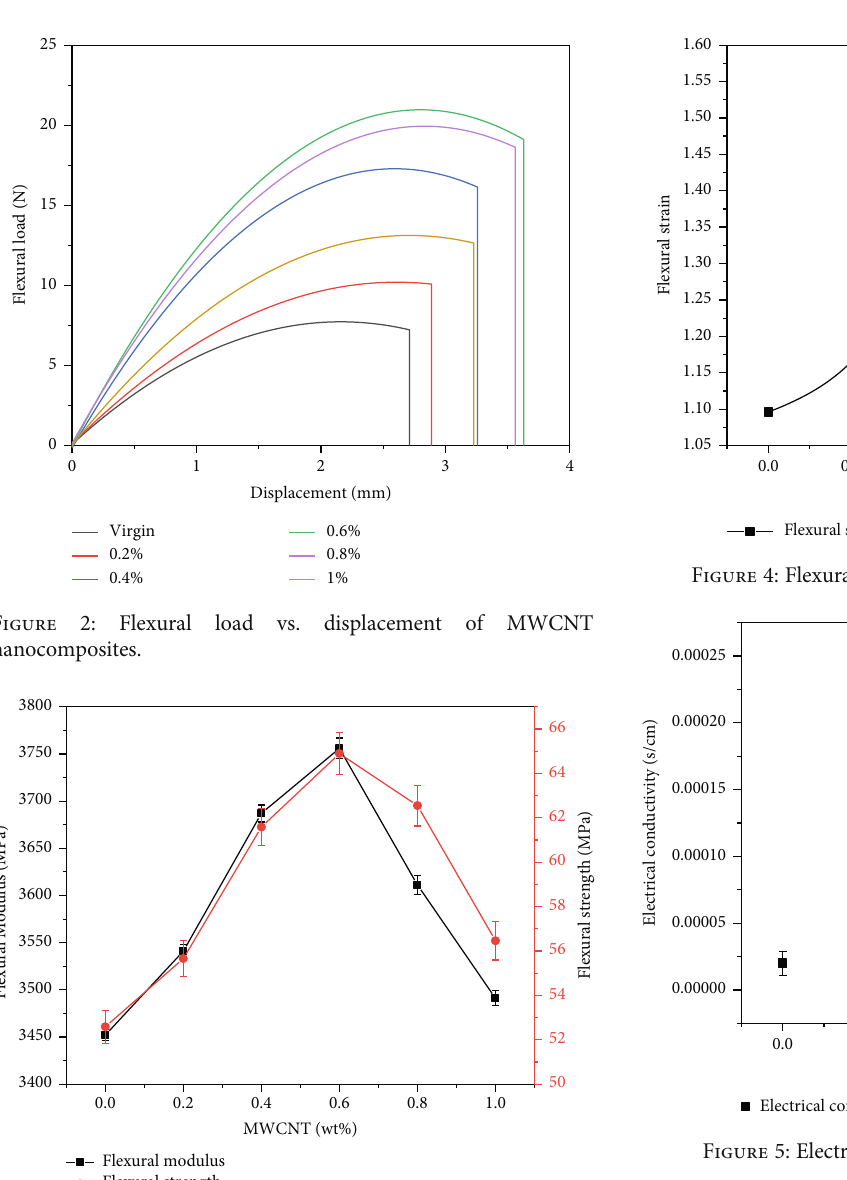
Figure 3: Flexural modulus vs. fl exural strength of MWCNT nanocomposites.